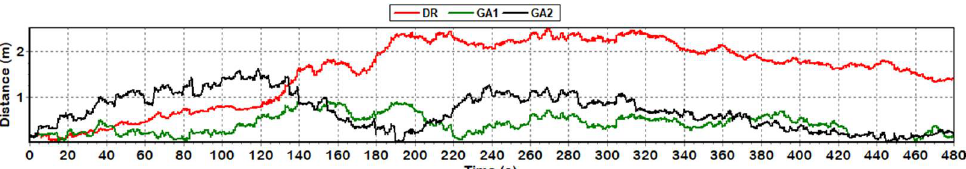
Figure 8. Distance to reference position from positions estimated using DR, GA1, GA2 methods as a function of time (single test sample).